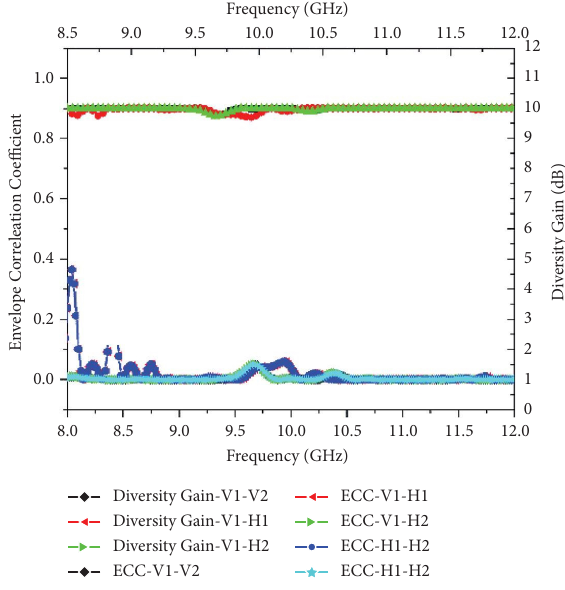
Figure 16: MIMO-Freq vs. ECC vs. DG.